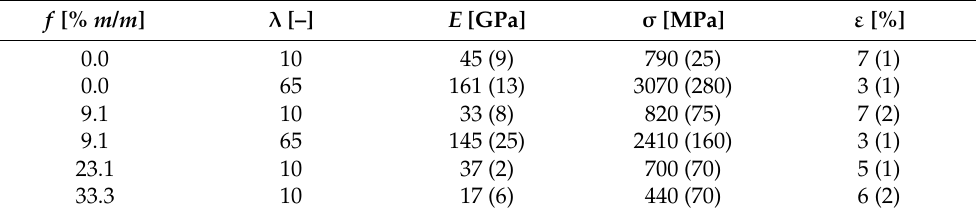
Table 2. Young’s modulus ( E ), tensile strength ( σ ) and strain at break ( ε ) of UHMWPE and UHMWPE–[Fe(NH 2 trz) 3 ](2ns) 2 ribbons prepared by gel-processing from stearic acid (formulation of 10% m / m UHMWPE in 90% m / m stearic acid) at different fractions of [Fe(NH 2 trz 3 )](2ns) 2 ( f ) with respect to UHMWPE and different draw ratios ( λ ). The standard deviations are indicated in brackets.